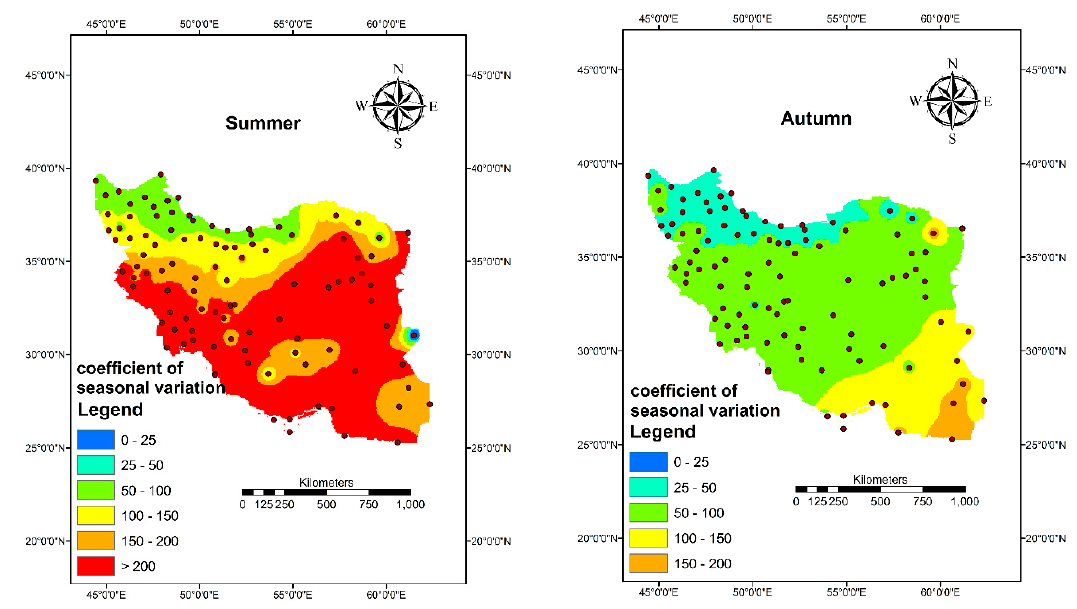
Figure 2. The long-term average of the precipitation and coefficient of variation (in percent) for Winter, Spring, Summer, and Autumn.